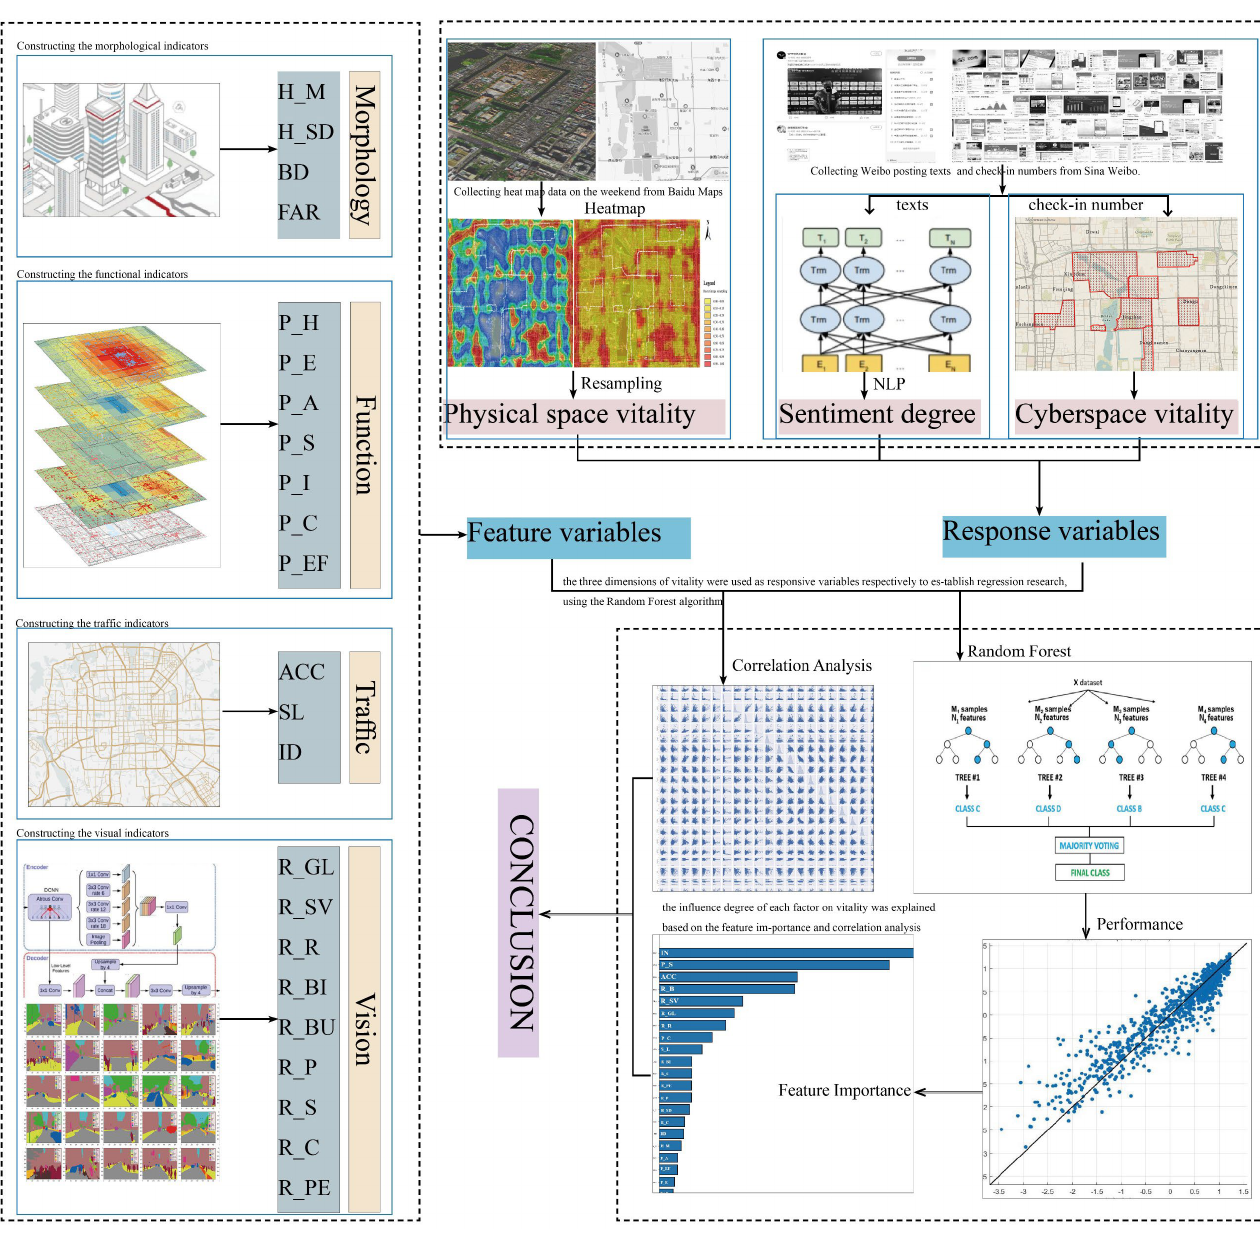
Figure 2. Workflow of this study.